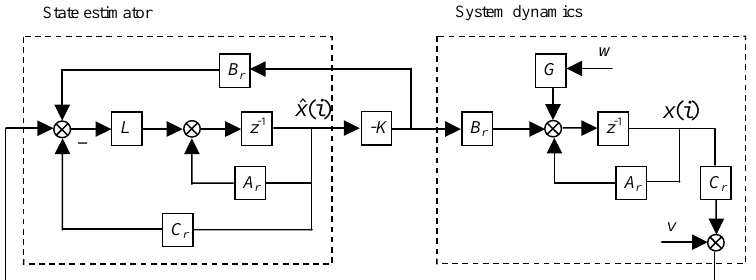
Fig. 1. A block diagram of the discrete-time LQG controller.